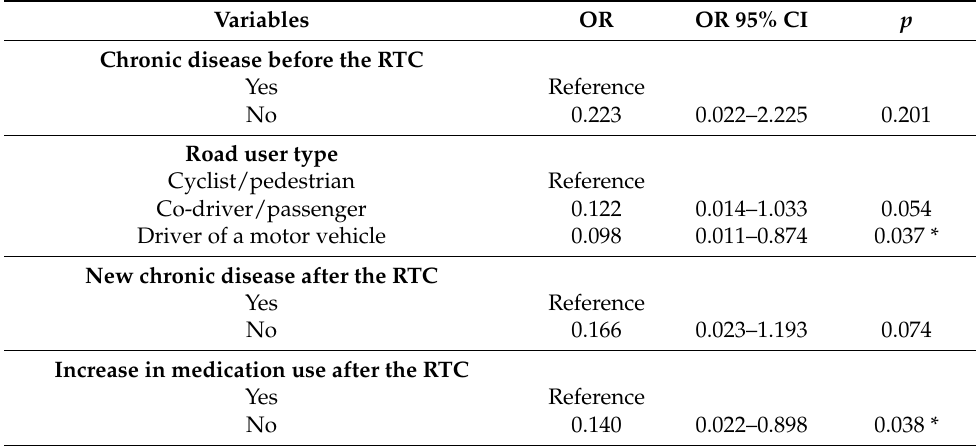
Table 10. The multivariable regression model for anxiety symptoms at 6-month follow-up. Variables OR OR 95% CI p Chronic disease before the RTC Yes Reference No Road user type Reference Co-driver/passenger